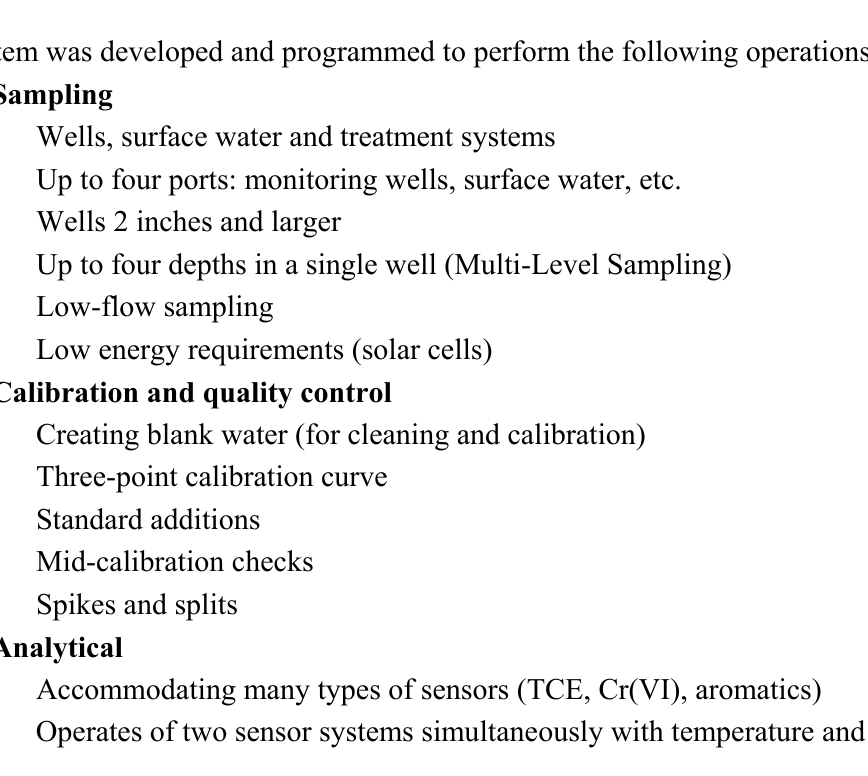
Figure 1. Site 100 D – Hanford site, Washington, hexavalent chromium groundwater plume. “Universal” sampling/ analytical